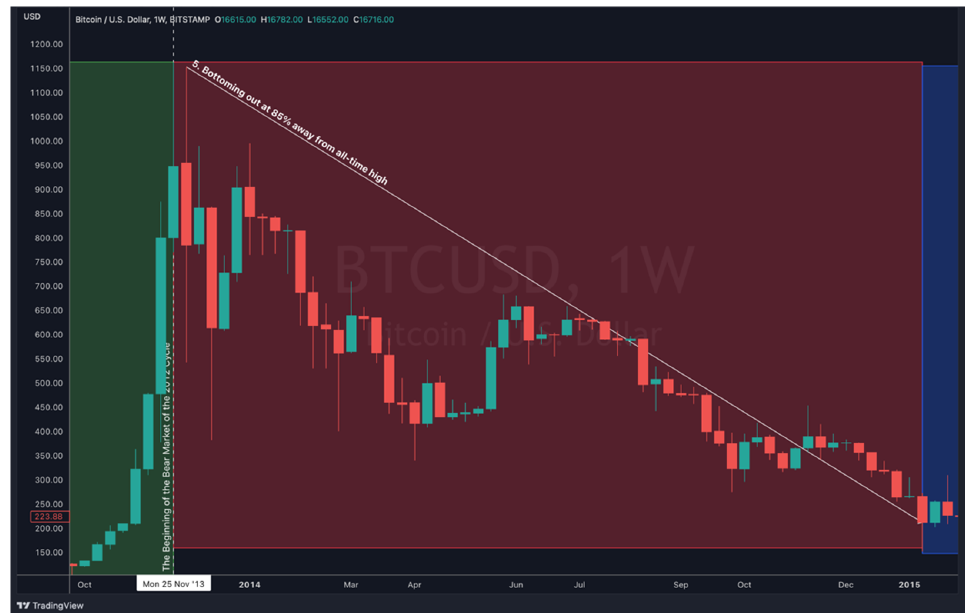
Figure 3. The 5th sequence of the 2014 bear market during the Bitcoin 2012–2016 halving cycle. The Bitcoin price finally bottomed at $200 (85% away from the historical all-time high) before entering the recovery phase.